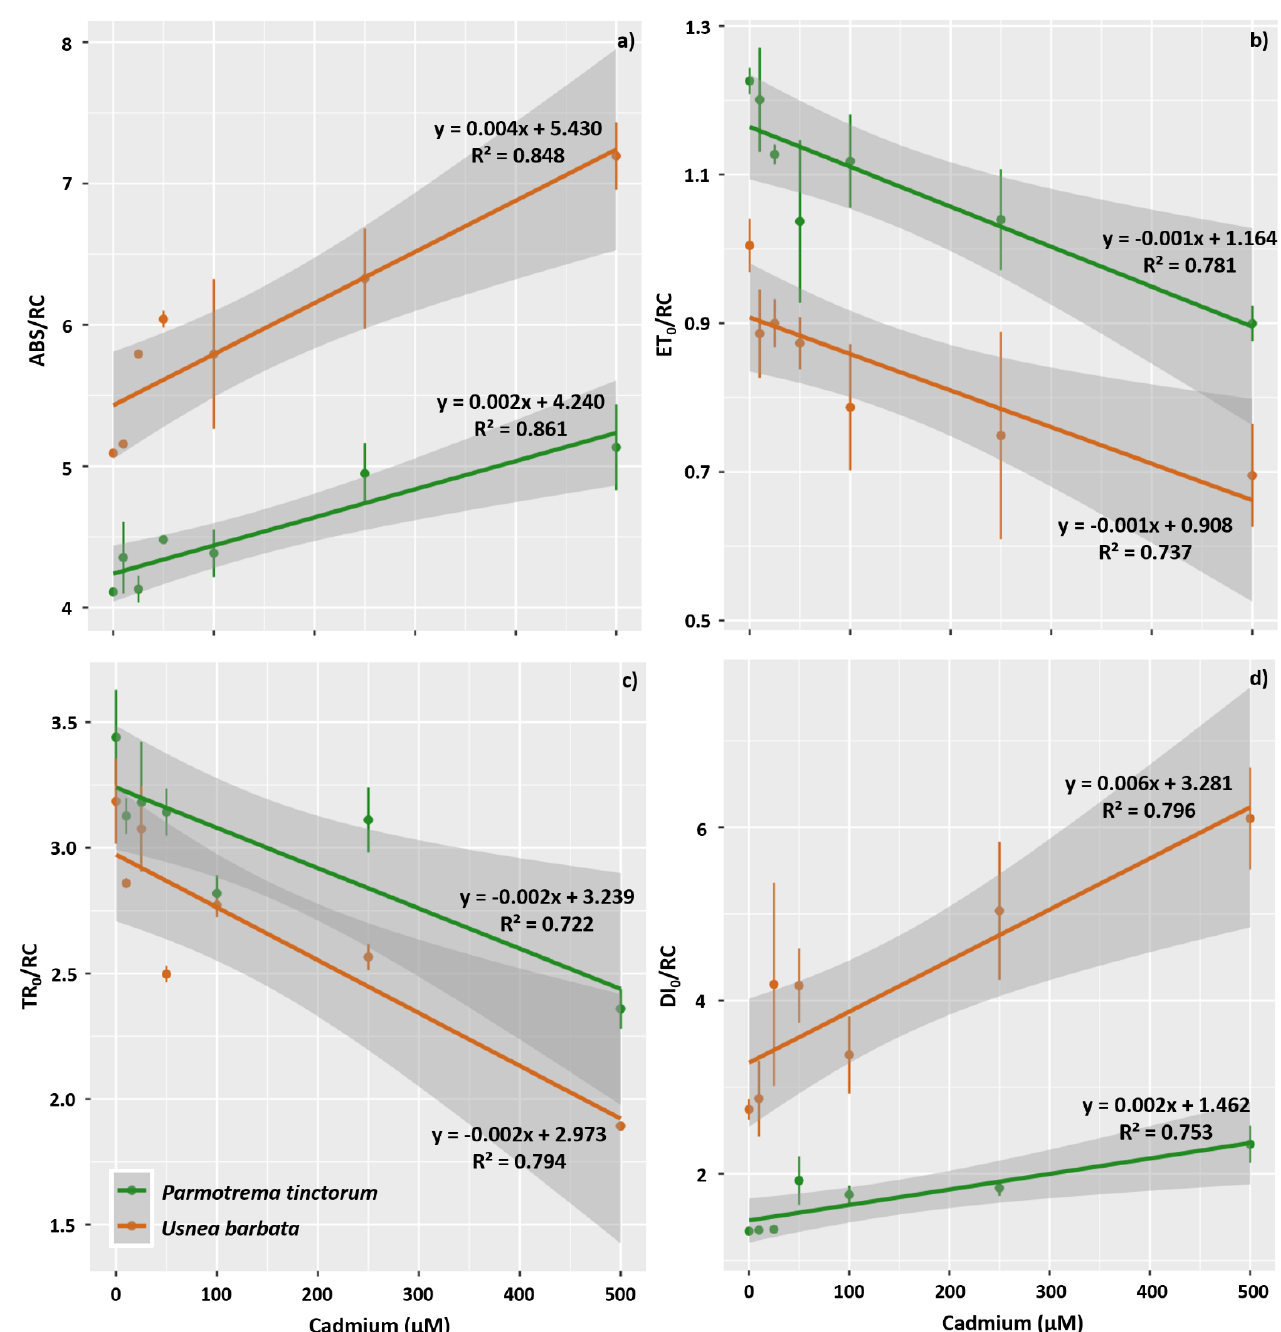
Figure 6. Chlorophyll a fluorescence parameters: ABS/RRC ( a ), ET0/RC ( b ), TR0/RC ( c ), and DI0/RC ( d ) observed for the photobiont of the lichen species Parmotrema tinctorum and Usnea barbata subjected to different concentrations of Cd (0, 10, 25, 50, 100, 250, and 500 µM). The straight lines represent the fitted model, and the prediction intervals (95%) are gray.